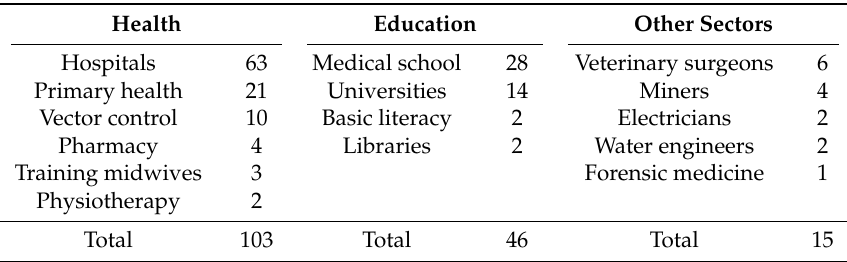
Table 5. Cuban professionals working in Huila Province, Angola, during 2010-2011. Health Education Other Sectors Hospitals 63 Medical school 28 Veterinary surgeons 6 Primary health 21 Universities 14 Miners 4 Vector control 10 Basic literacy 2